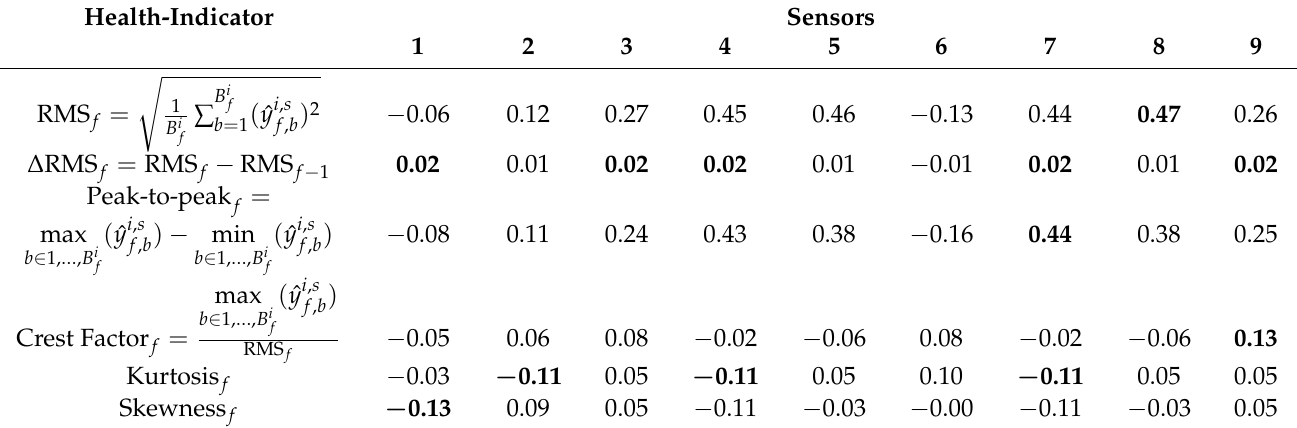
Table 1. Overview of the considered health indicators. For each sensor, the correlation coefficient between the health indicator and the time to failure is given. The highest absolute correlation coefficient is given in bold.